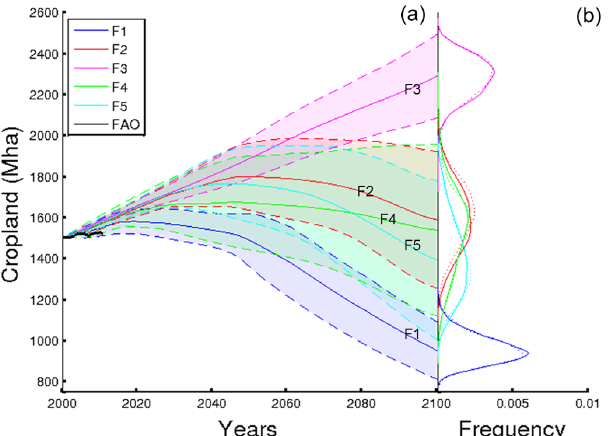
Figure 3. (a) Cropland development from 2000 to 2100 for the five cropland futures (solid line: mean; range with dashed lines: ± 2 standard deviations). (b) PDFs fitted to all runs for each sce- nario in 2100, solid lines are runs with sampling yield variations due to GCM patterns and the scenario matrix, and dashed lines are runs where the mean yield was